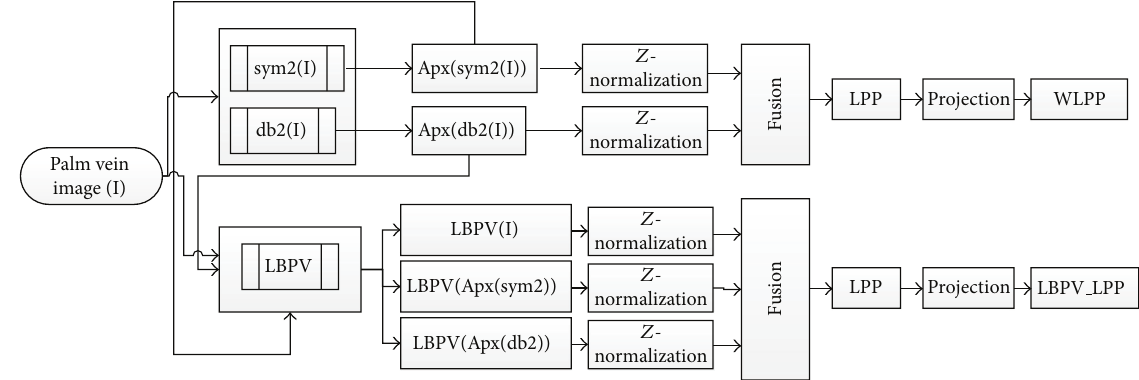
Figure 7: Flowchart of the feature vectors extraction.